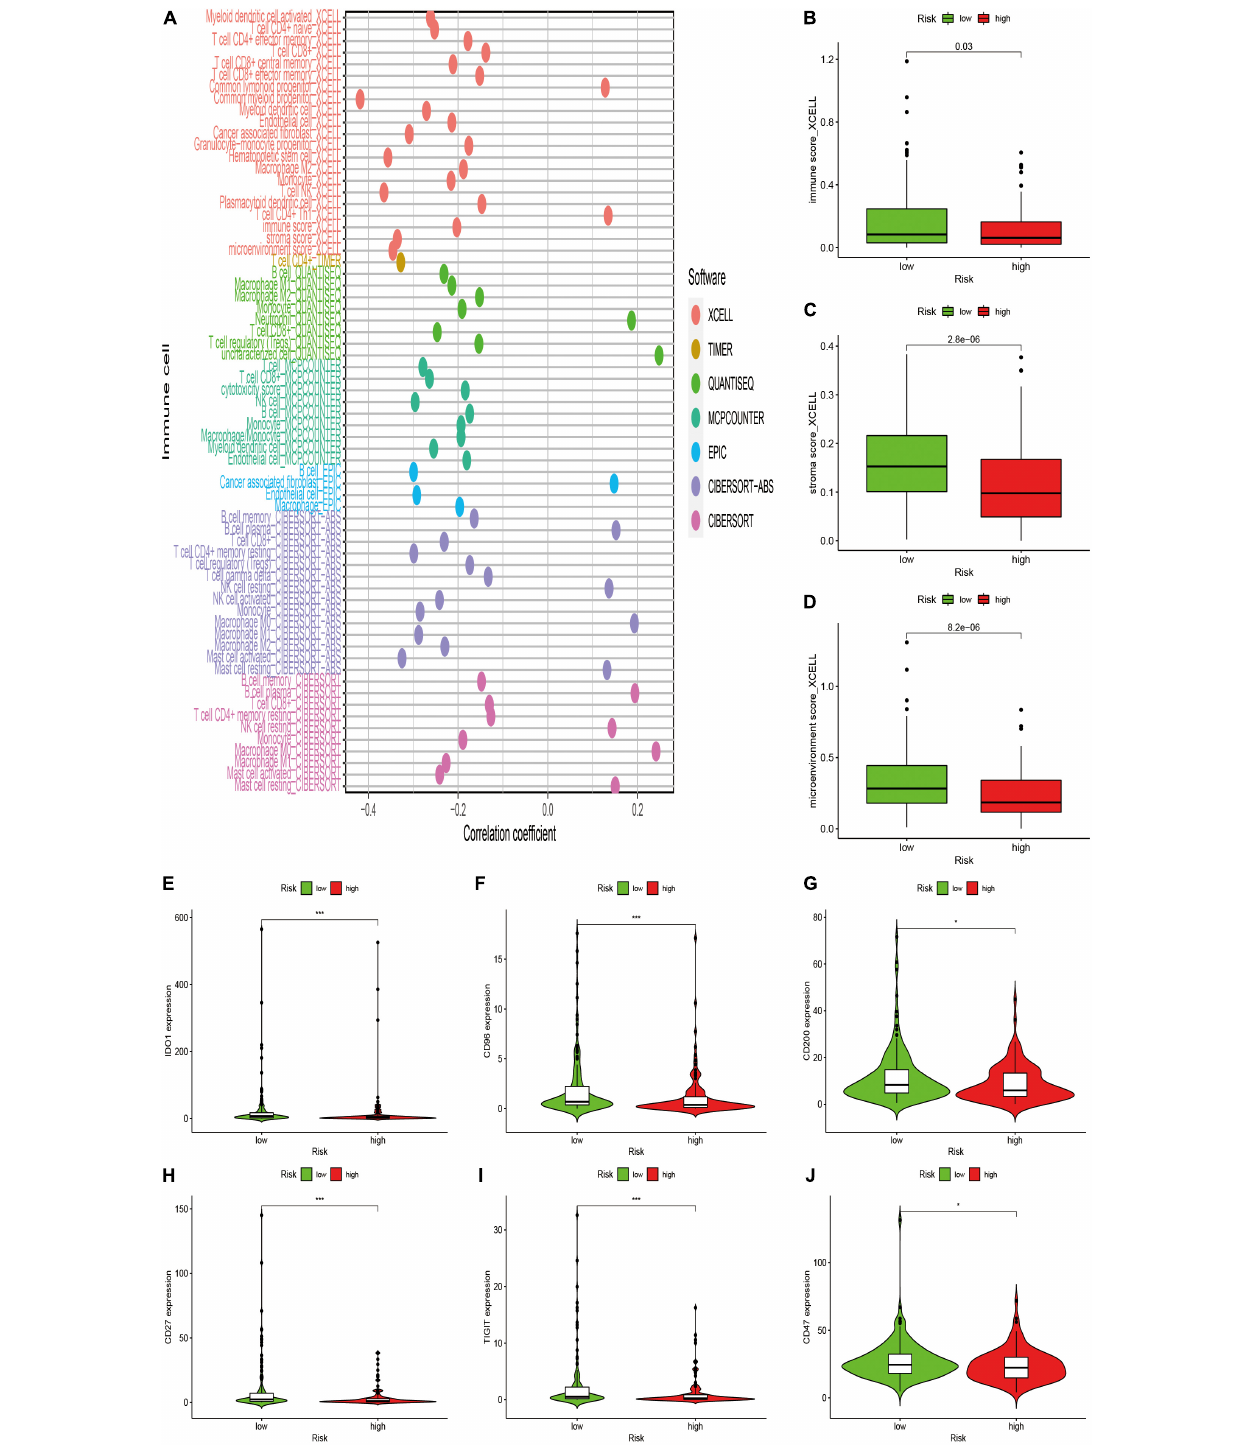
FIGURE 5 | Estimation of the associations between immune characteristics and the risk signature. (A) Diagram of Spearman correlation analysis between immune cells infiltration and the risk signature. Patients in the high-risk group were more positively associated with tumor-infiltrating immune cells such as macrophage M0, and NK resting cells, whereas they were negatively associated with CD8+ T cells, CD4+ T cells, and monocytes. (B–D) The correlation between the risk signature and immune score by XCELL. Patients in the high-risk group had a lower (B) immune, (C) stromal scores, and (D) microenvironment scores. (E–J) The expression levels of immune checkpoints in the high-risk and low-risk groups. High risk scores were negatively correlated with upregulated (E) IDO1, (F) CD96, (G) CD200, (H) CD27, (I) TIGIT, and (J) CD47 levels.